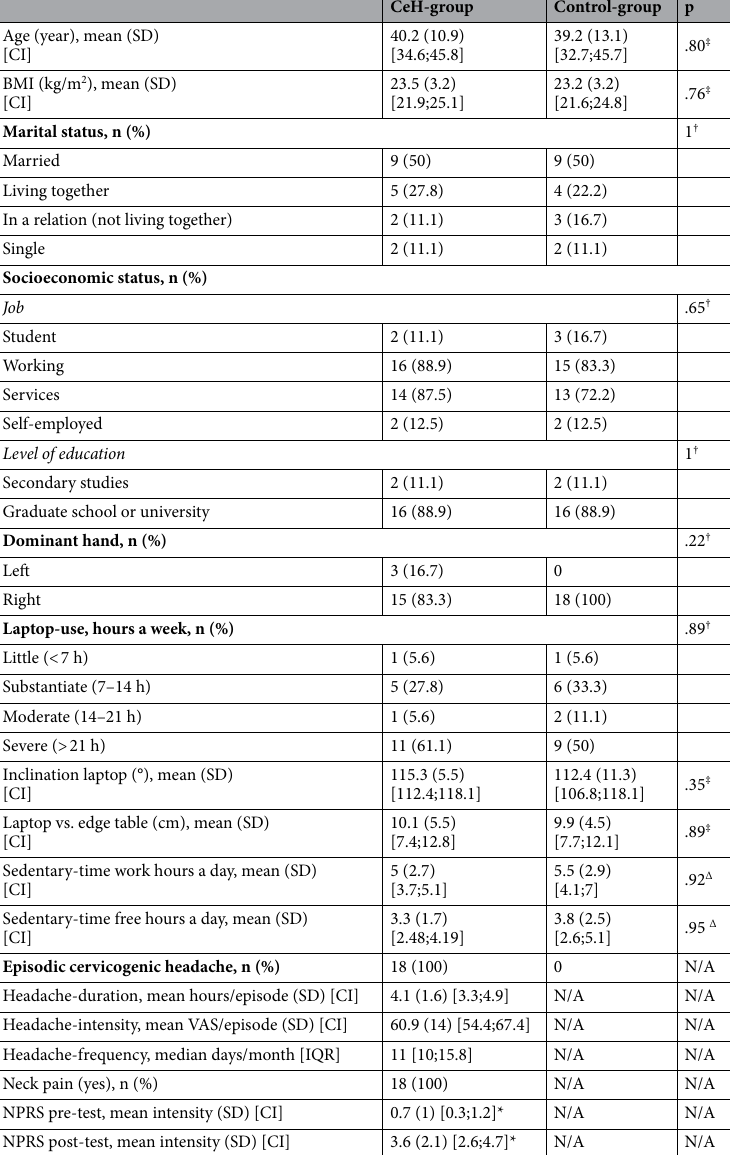
Table 2. Demographics and group characteristics of the CeH-group (n = 18) and control-group (n = 18). y years, n number participants, VAS 100 mm Visual Analogue Scale (0 = no paint, 10 = worst pain), t-test; † Contingency table for categorical variables (Fisher’s exact test); Δ Mann Whitney Test; *NPRS pre laptop- task was significantly (p < .0001, Wilcoxon Signed Rank test) lower (effect size = 0.89) compared to NPRS post laptop-task. Data on headache characteristics were deducted from the 4-week